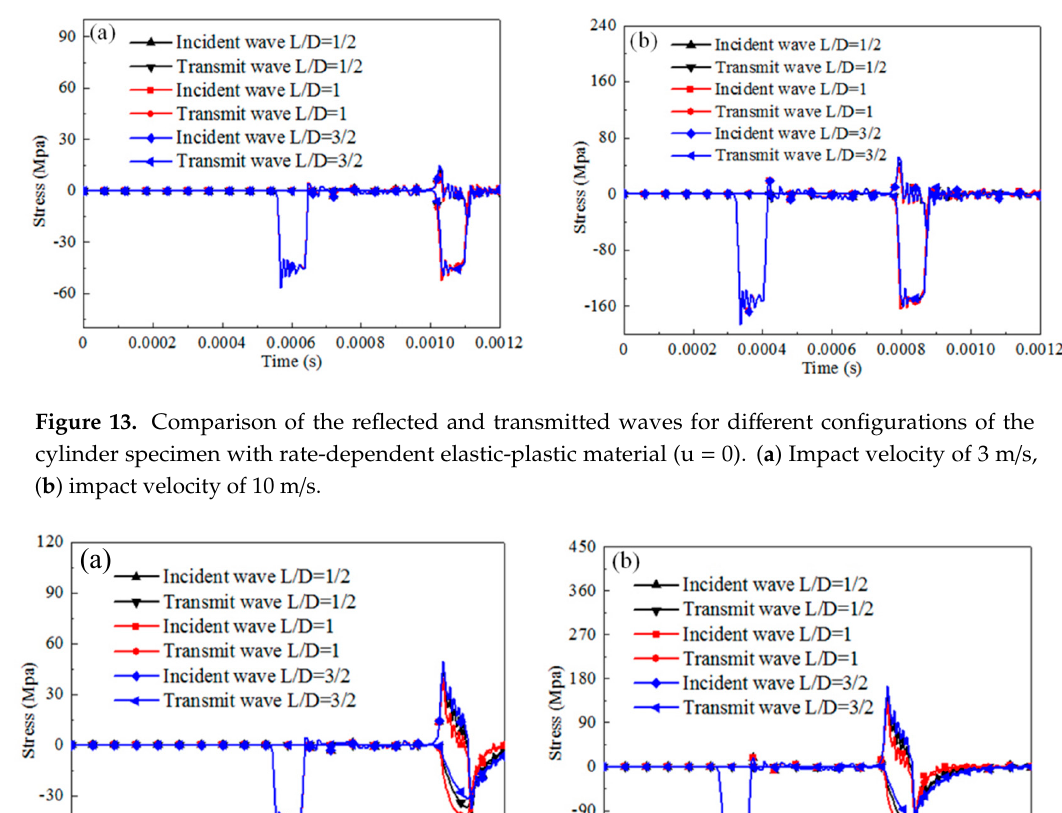
Figure 12. Comparison of the reflected and transmitted waves for different configuration cylinder specimens with rate-independent material (u = 0). ( a ) Impact velocity of 3 m/s, ( b ) impact velocity of 10 m/s.